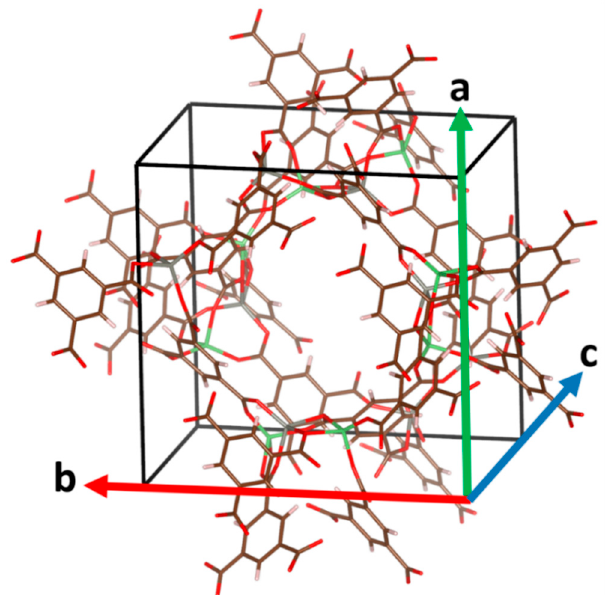
Figure 1. Experimental structure of Li 8 Zn 8 H 24 C 72 O 48 MOF (reference code: WAJJAU). The unit cell is bounded by black lines. The directions in which the lattice constants a , b , and c are measured are shown as green, red, and blue arrows, respectively.